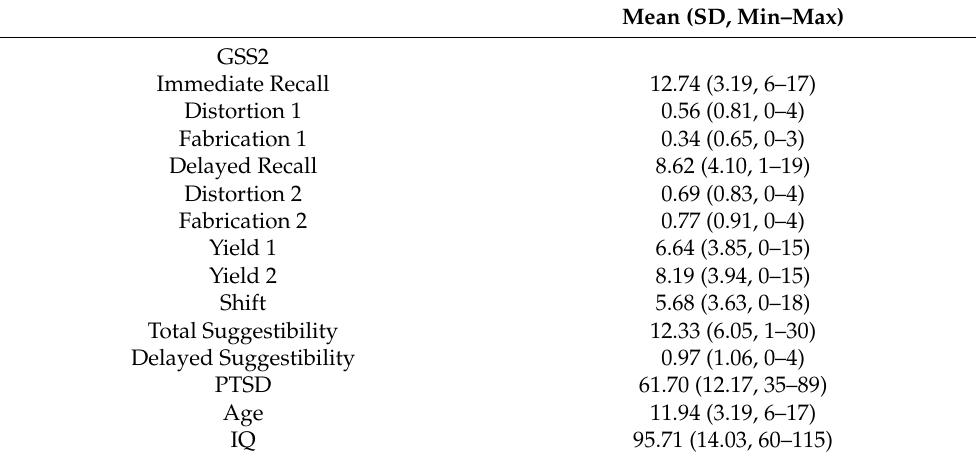
Table A1. Average scores on age, GSS2, and post-traumatic stress disorder (PTSD) ( n = 221).